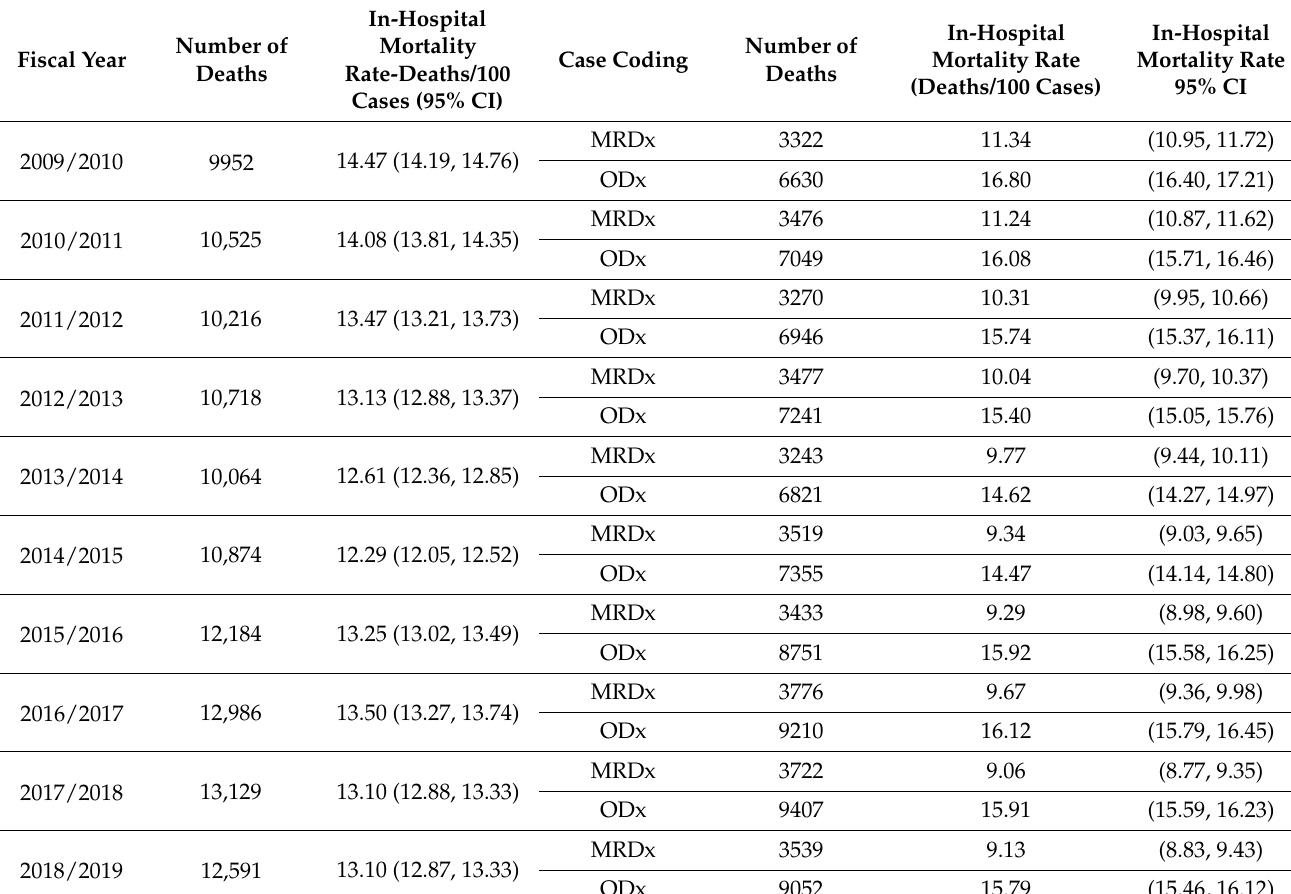
Table 3. In-hospital mortality rate for all-cause community-acquired pneumonia among adults ≥ 50 years of age, overall and by case coding, in fiscal years 2009–2018, Canada (excluding